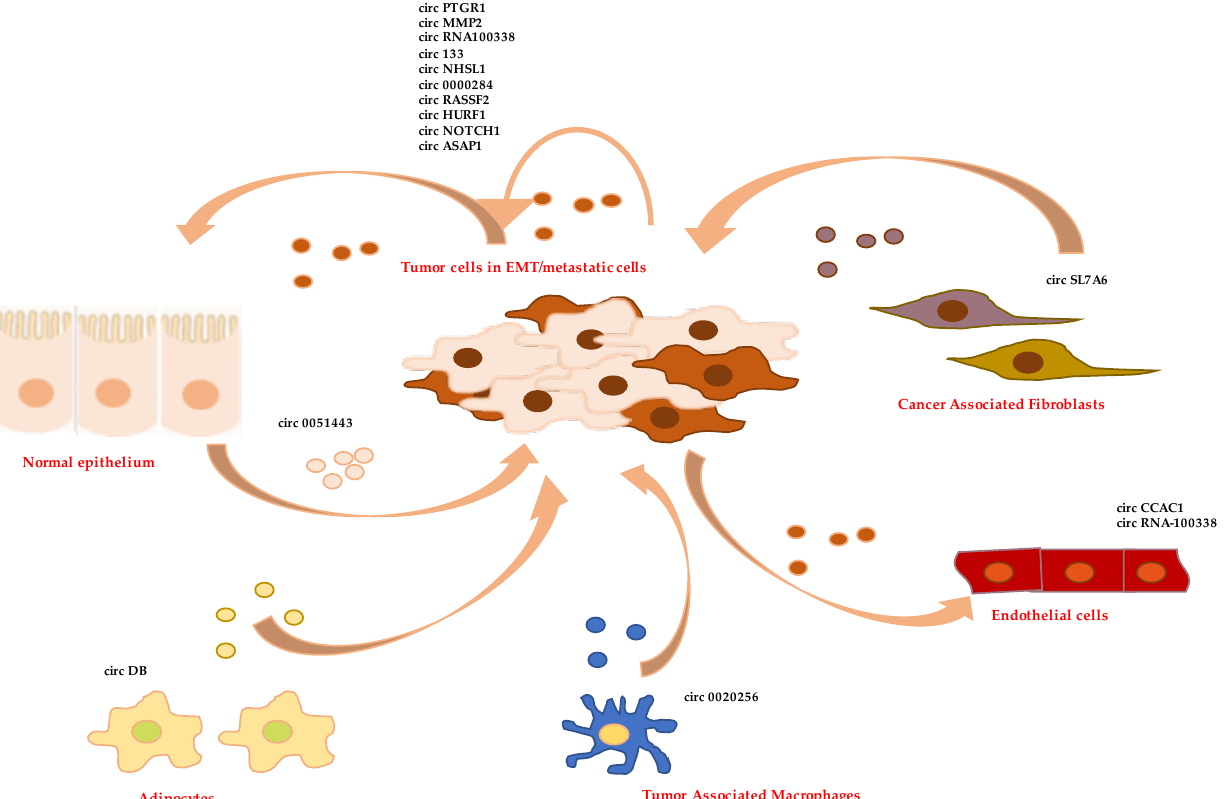
Figure 3. Exosome-mediated cell-to-cell communication in TME. Exosomes-associated pro- and anti-EMT circRNAs in the communication between tumor cells and surrounding microenvironmental elements, including normal epithelial cells, tumor-associated macrophages, endothelial cells, cancer- associated fibroblasts, and